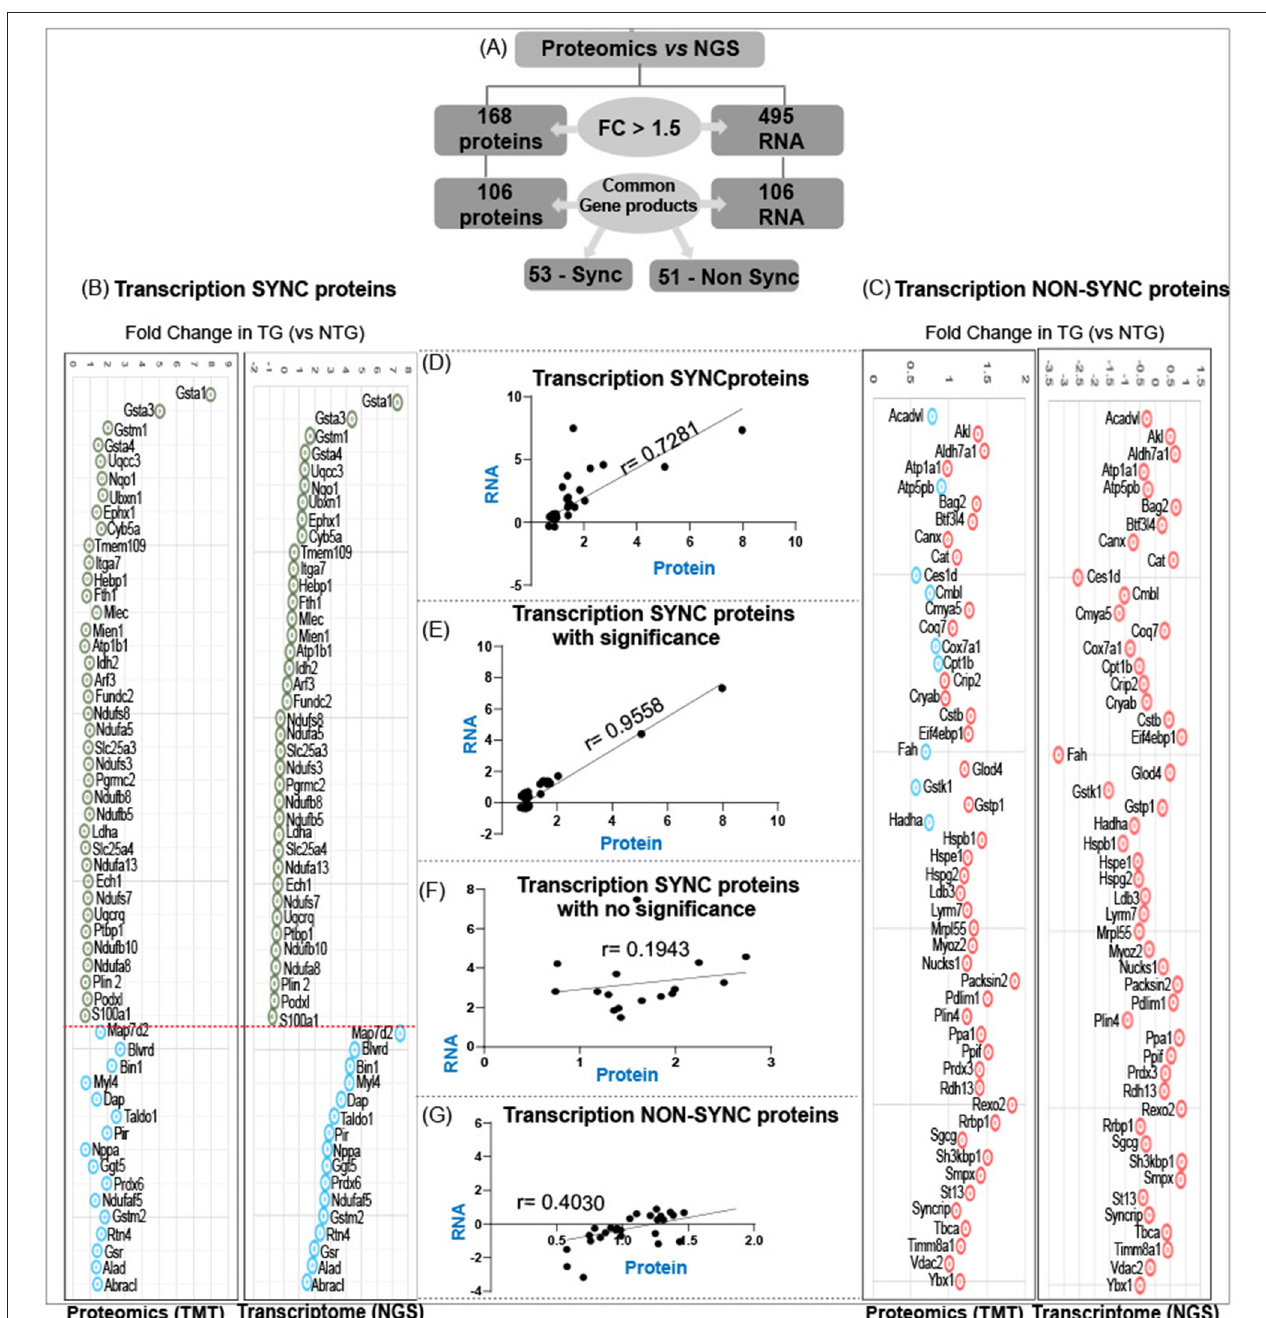
FIGURE 3 | Analysis of transcription-sync versus transcription-non sync proteins in RS hearts. (A) Out of 106 commonly found gene products in NGS (RNA) and respective translational products (proteins by TMT) at a FC > 1.5, the levels of 50 proteins are not consistent with their RNA levels (either up or down regulated). Proteins that are steadily expressed according to their respective mRNA levels are classified as “transcription-sync proteins” (B) and the ones that do not match with their mRNA levels are termed as “transcription-nonsync proteins” (C) . (D,E) A strong positive correlation ( r = 0.955) was observed among 38 of transcription-sync proteins (C) , but a weak positive correlation ( r = 0.194) for 16 transcription-sync proteins (F) . Transcription-nonsync proteins showed a negative correlation (G) . inhibition of translation, or due to modified amino